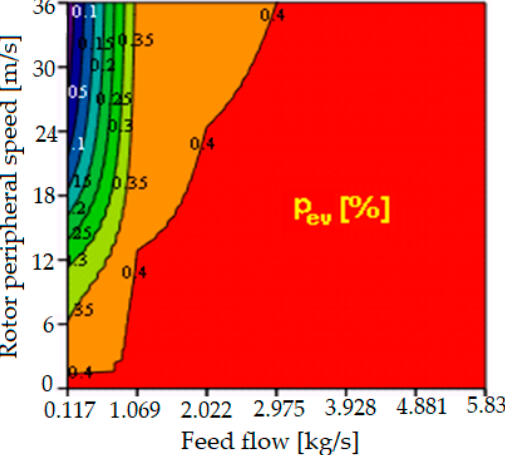
Figure 13. Graphical representation of evacuation losses ( p ev ) as a function of rotor peripheral speed ( v p ) and feed flow ( Q ).